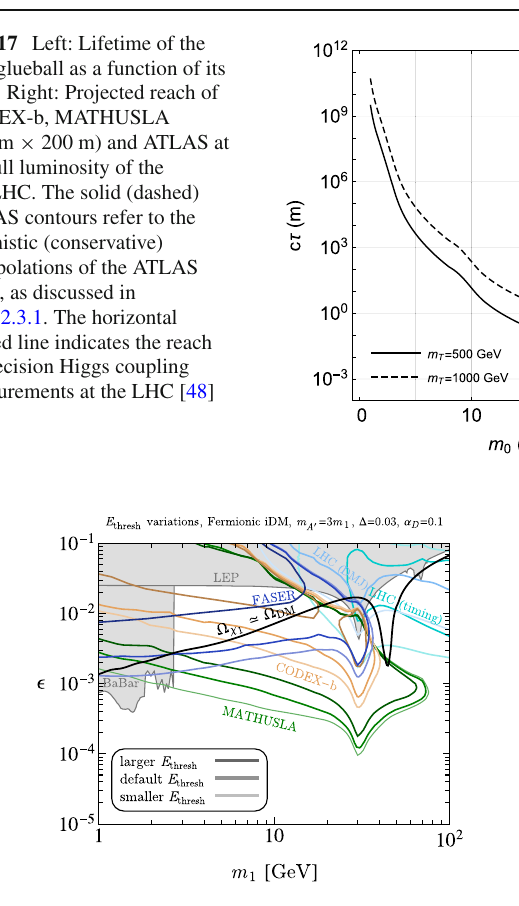
Fig. 18 Sensitivity estimates for the inelastic dark matter benchmark, reproduced from Ref. [128] with permission of the authors. The black line indicates the line on which the correct dark matter relic den- sity is predicted by the model. Darker/lighter shades correspond to larger/smallerminimum energy thresholds for the decayproducts of χ 2 , with CODEX-b shown in orange shades. For CODEX-b and MATH- USLA (200 m × 200 m), the minimum energy is taken to 1200, 600, or 300MeV per track. For FASER2 (1 m radius), the total visible energy deposition is taken to be greater than 200, 100, or 50GeV. For a dis- placed muon-jet search at ATLAS/CMS and a timing analysis at CMS with a conventional monojet trigger, the minimum required transverse lepton momentum is 10, 5, or 2 . 5GeV and 6, 3, or 1 . 5GeV,